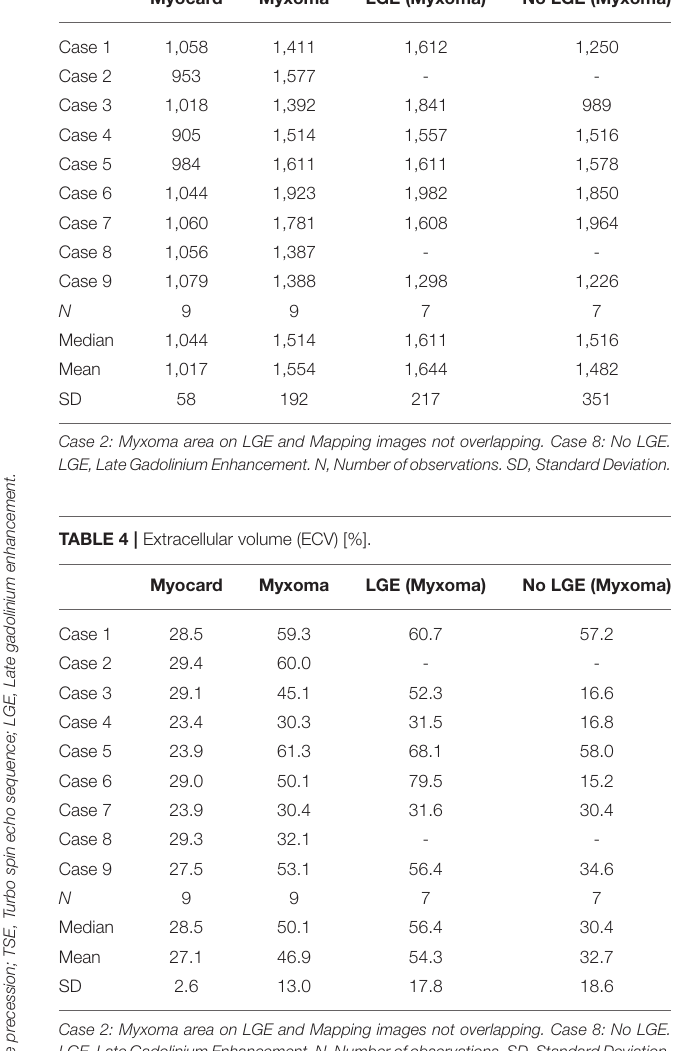
performed for MR parameters (T1, T2, and ECV) vs. histological parameters (fibrosis and mucopolysaccharide volume).